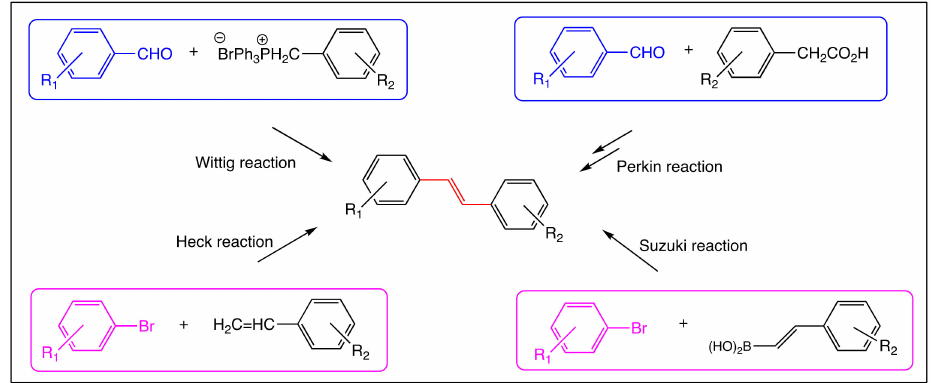
Figure 3. Principal synthetic methods for obtaining stilbene derivatives: Wittig method [25], Perkin method [43], Heck method [25] and Suzuki method